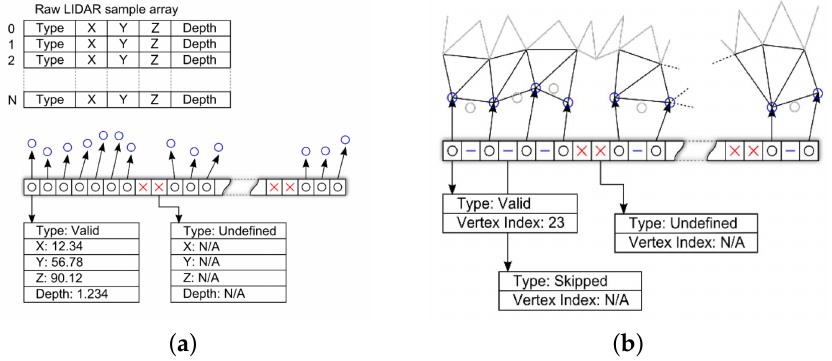
Figure 15. Data structure representing a line of raw LIDAR points ( a ); and the current edge of a mesh being created ( b